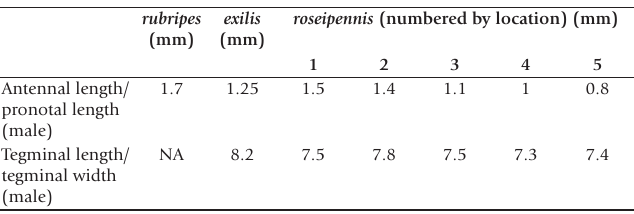
Table 3. Geographical variation in morphometric ratios amongst